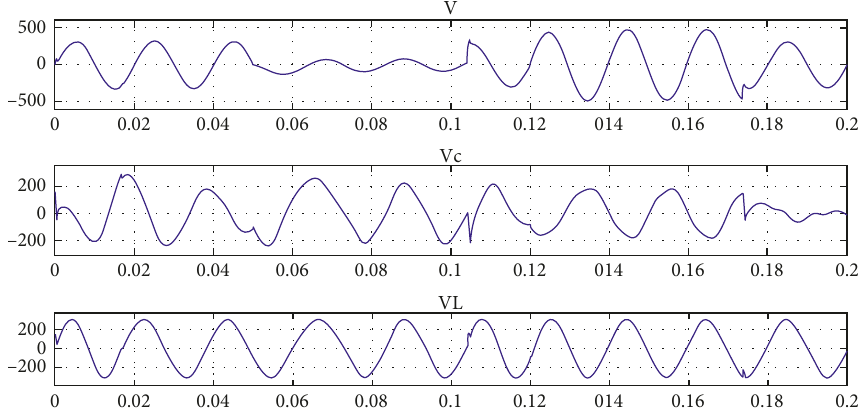
Figure 14: Result of the DVR system simulation by traditional strategy.